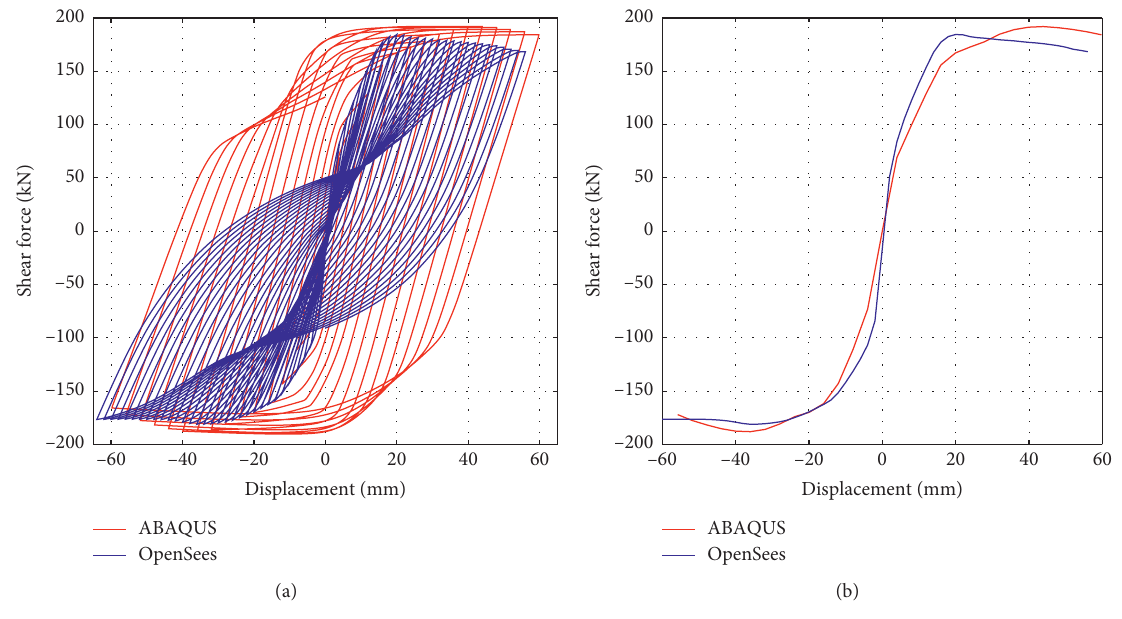
Figure 13: Hysteretic curves and skeleton curves.